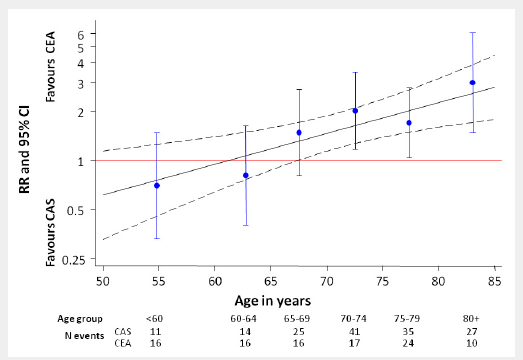
Pooled Individual patient-data meta-analysis of the EVA-3S, SPACE and ICSS trials, comparing primary carotid stenting with endarterectomy for symptomatic carotid stenosis: risk ratio of any stroke or death within 120 days of randomisation according to patient age. (Reproduced from [20]: Bonati LH, Dobson J, Algra A, Branchereau A, Chatellier G, Fraedrich G, et al. Short-term outcome after stenting versus endarterectomy for symptomatic carotid stenosis: a preplanned meta-analysis of individual patient data. Lancet. 2010;376(9746):1062–73. © Elsevier, Oxford, UK. Reprint with kind permission.)